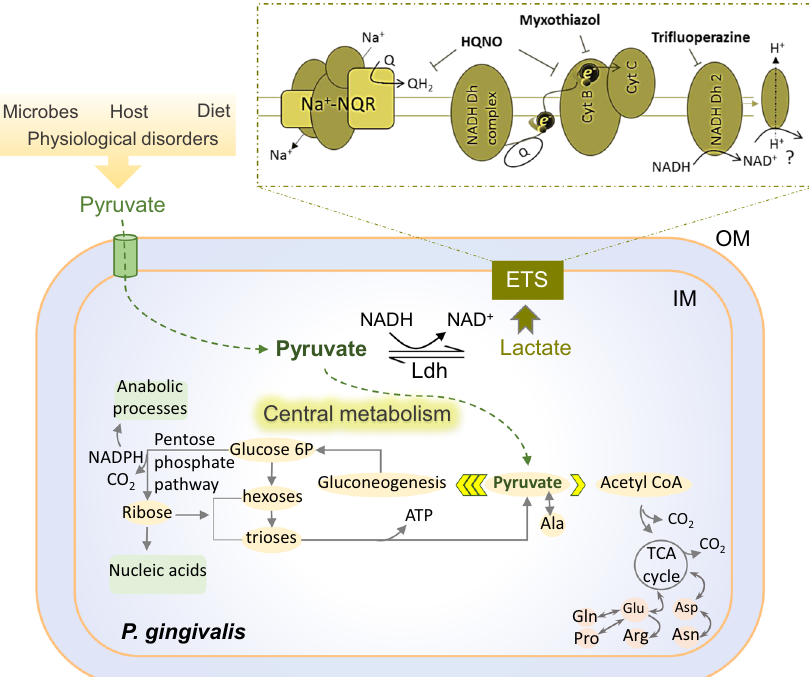
Fig. 7 Proposed model of possible bioenergetics system and metabolism of the monocarboxylates pyruvate and lactate in P . gingivalis that are deduced from the effectiveness of applied uncouplers in RF assay and metabolomic analysis. Pyruvate availability in the intracellular and extracellular milieu of host cells is impacted by various external factors. P. gingivalis ef fi ciently transports exogenous pyruvate inside to couple with the metabolism of serum components toward the enhancement of the PPP intermediates that are required for biosynthetic processes, resulting in the increase of cell proliferation and biomass in the bio fi lm community. ETS electron transport system, Ldh lactate dehydrogenase, Cyt cytochrome, NADH Dh NADH dehydrogenase, Na + – NQR the sodium pumping NADH quinone oxidoreductase, Q quinone, e electron, NAD nicotinamide adenine dinucleotide, NADPH nicotinamide adenine dinucleotide phosphate, Glucose 6P glucose-6- phosphate, Glu glutamic acid, Asp aspartic acid, Gln glutamine, Pro proline, Arg arginine, Asn asparagine, Ala alanine, ATP adenosine triphosphate; HQNO 2-heptyl-4-hydroxyquinoline N-oxide, IM inner membrane, OM outer